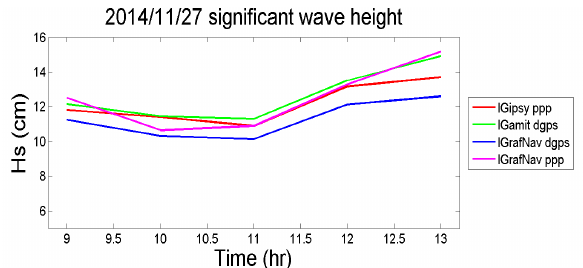
Figure 12(c). Significant wave height of integration